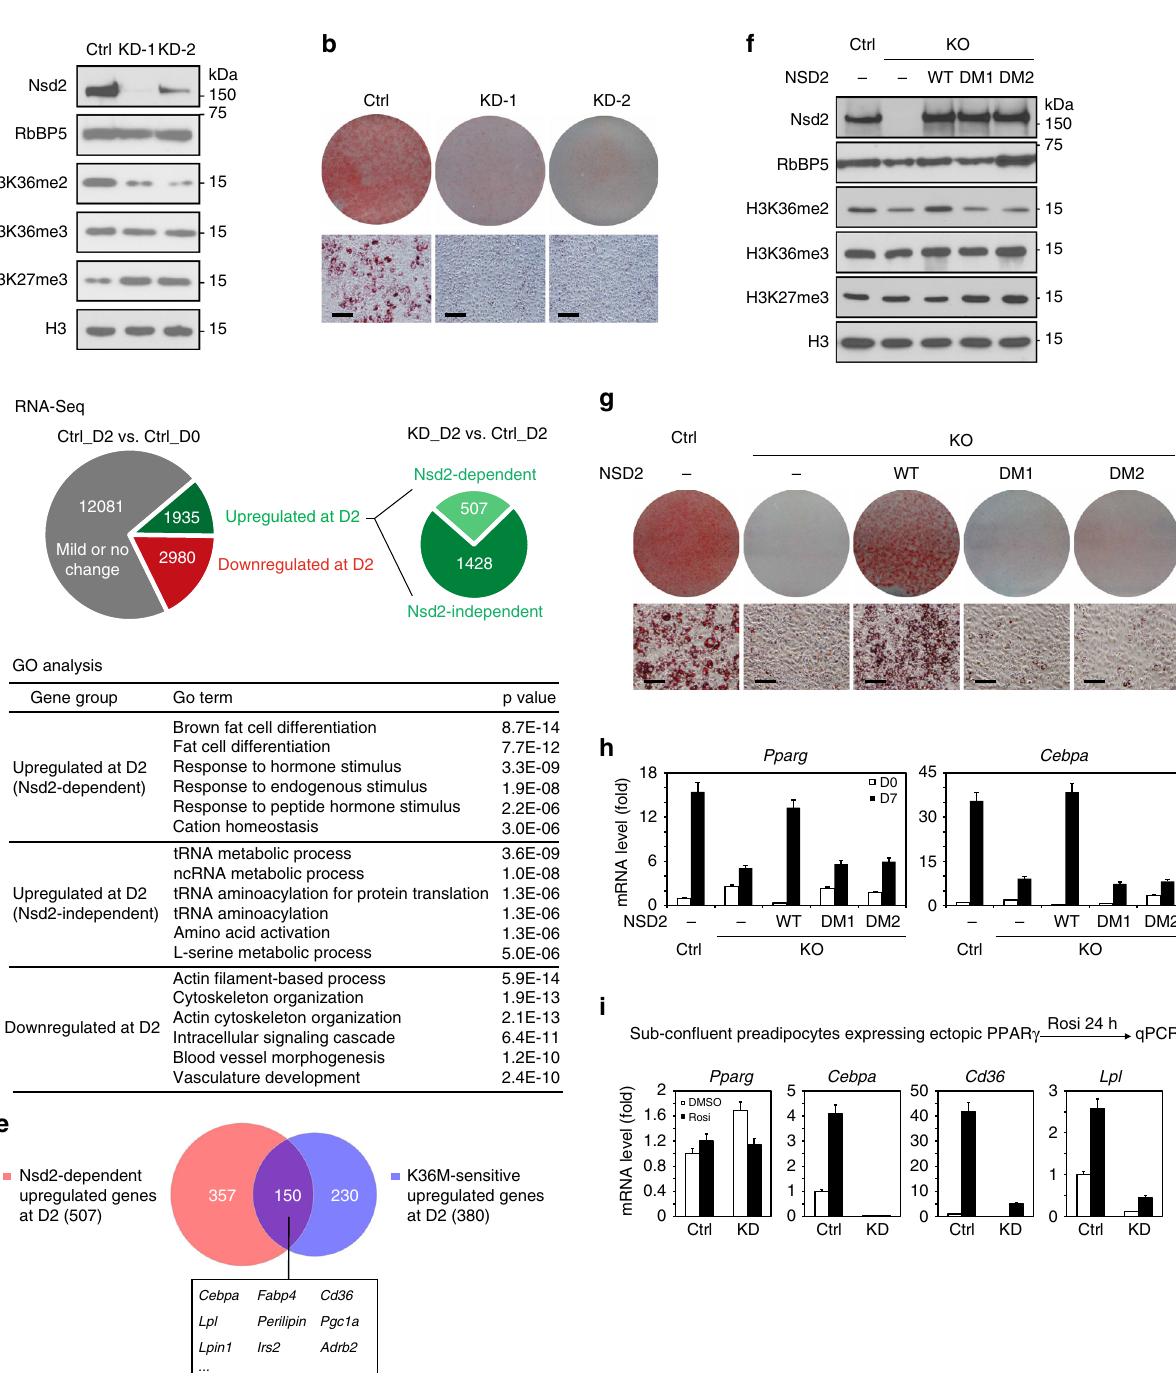
Fig. 3 H3.3K36M targets H3K36 methyltransferase Nsd2 to inhibit adipogenesis and PPAR γ target gene expression. a – e Immortalized brown preadipocytes were infected with lentiviral vector expressing control (Ctrl) or Nsd2 knockdown (KD) shRNAs, followed by adipogenesis assay until D7. Cells were collected at D0 and D2 for RNA-Seq. a Western blot of Nsd2 and histone methylations in preadipocytes. RbBP5 and histone H3 were used as loading controls. b Oil Red O staining at D7 of adipogenesis. Scale bars = 30 μ m. c Schematic identi fi cation of Nsd2-dependent and Nsd2-independent up- regulated genes at D2 of adipogenesis. The threshold for up-regulation or down-regulation is twofold. d GO analysis of gene groups de fi ned in c . e Venn diagram depicting Nsd2-dependent (507) and K36M-sensitive (380) up-regulated genes at D2. f – h Nsd2 methyltransferase activity is required for adipogenesis. Nsd2 knockout (KO) preadipocytes were generated using CRISPR. Control (Ctrl) and Nsd2 KO cells were infected with retroviral vector expressing either WT, Y1092A/Y1179A mutant (DM1), or H1042G/Y1179A mutant (DM2) human NSD2, followed by adipogenesis assay. f Western blot of Nsd2 and histone methylations in preadipocytes. g Cells were stained with Oil Red O at D7 of adipogenesis. Scale bars = 30 μ m. h qRT-PCR of Pparg and Cebpa expression at D0 and D7 of adipogenesis. i Nsd2 is required for ligand-induced PPAR γ target gene expression. Ctrl or Nsd2 KD preadipocytes were infected with retroviral vector expressing PPAR γ . Sub-con fl uent cells were treated with DMSO or 0.5 μ M Rosi for 24 h, followed by qRT-PCR of Pparg and its target genes Cebpa , Cd36 , and Lpl . All qRT-PCR data are presented as means± SEM. Three technical replicates from a single experiment were